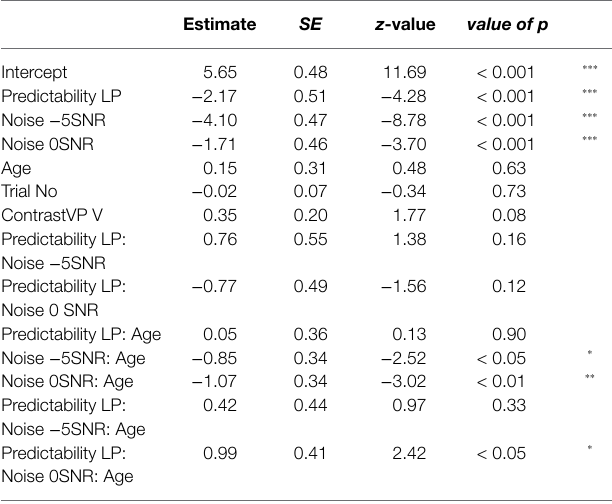
TABLE 3 | Model outcomes for the confidence rating analysis (target